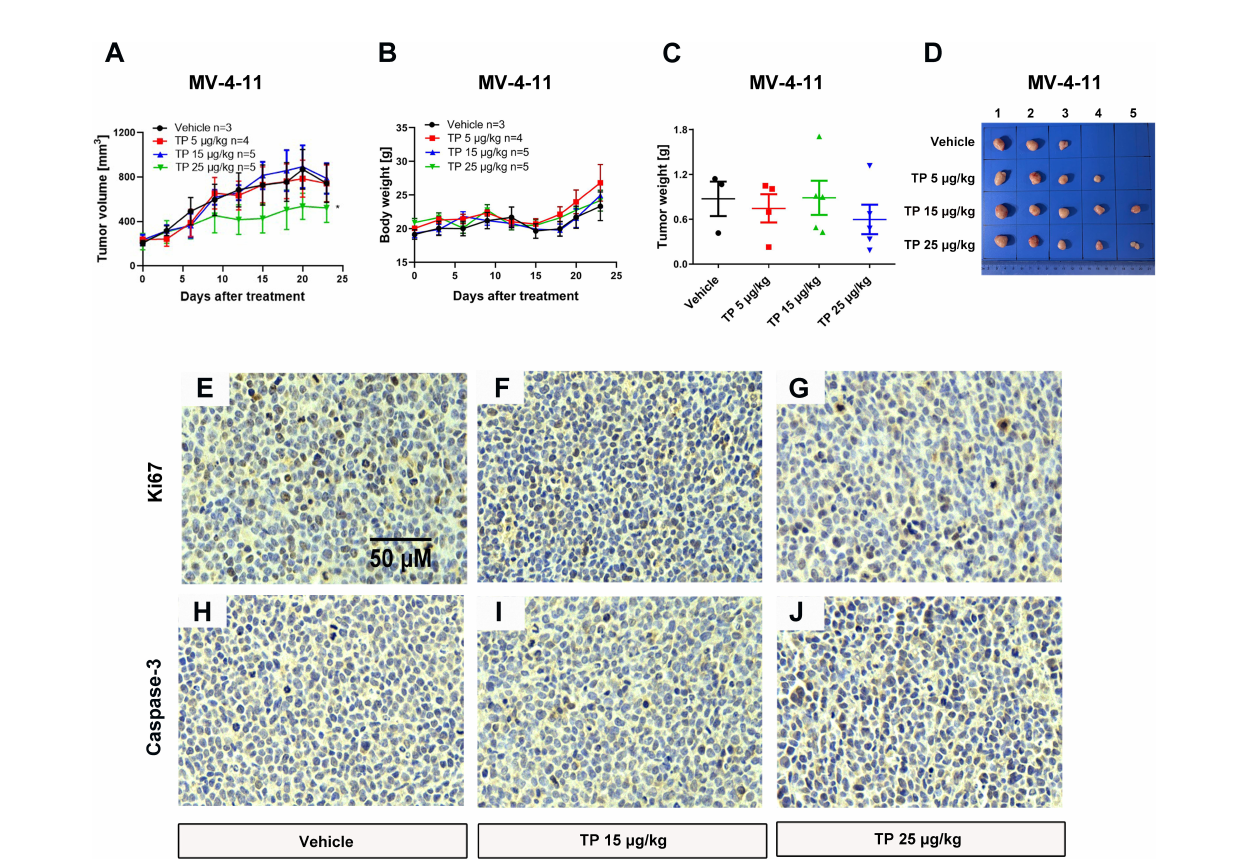
FIGURE 4 | Low-dose triptolide shows a mild anti-AML activity in a MV-4-11 xenograft. 5×10 6 MV-4-11 cells were injected into BALB/C nude mice subcutaneously. When the tumor volume reached 200 mm 3 , mice were randomly assigned to four treatment groups and treated with triptolide of 5, 15, and 25 m g/kg/day via an intraperitoneal injection for 24 consecutive days. Tumor volume (A) and bodyweight (B) was measured every two days. At the end of the study, tumors were weighed (C) and photographed (D) . * p < 0.05. Representative photos of tumor sections stained with Ki67 (E – G) and Caspase-3 (H – J) were